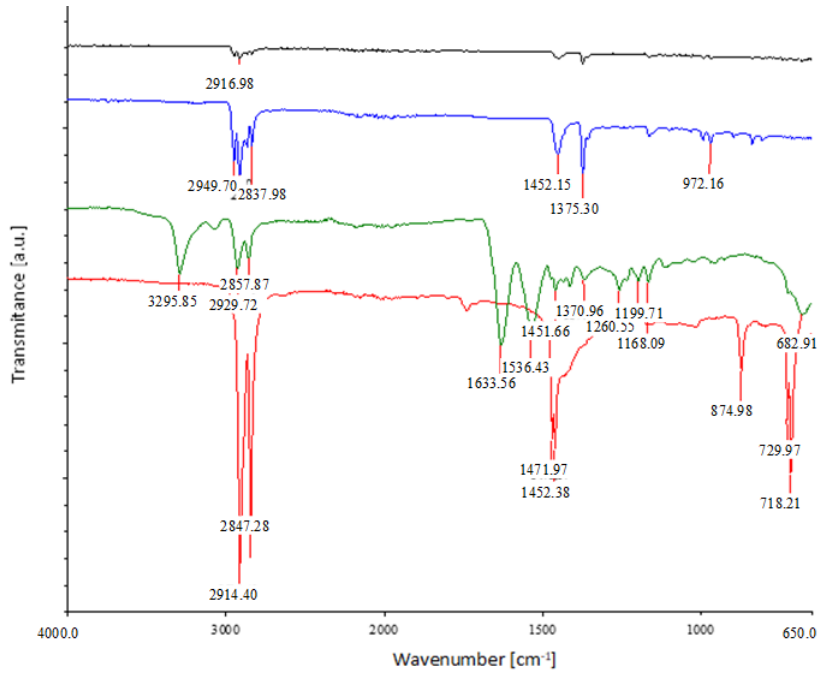
Figure 7. FTIR spectra of the back (black spectrum) and front (blue spectrum) nonwoven layer, the ear loops (green spectrum), and nose pads (red spectrum) of the medical mask.